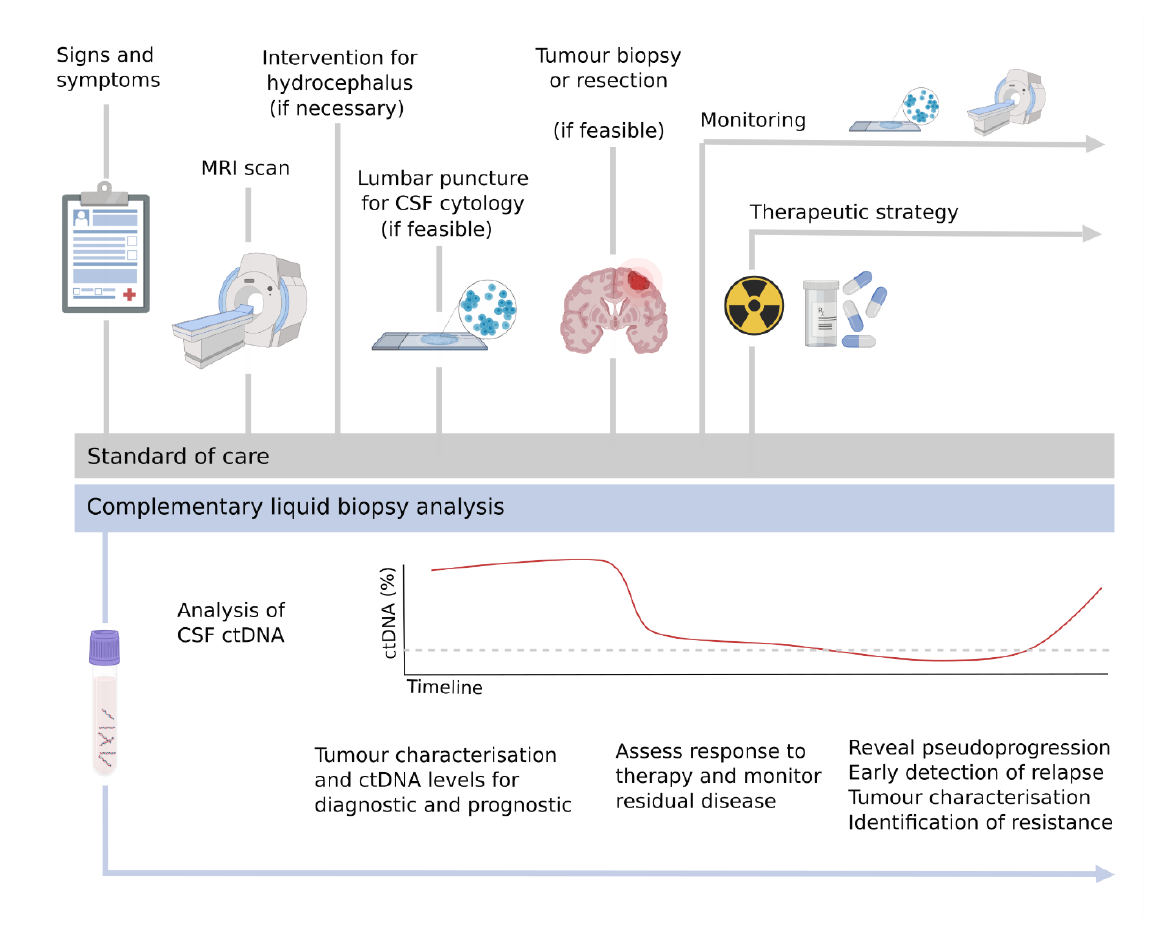
Figure 2. Liquid biopsies in the clinical setting. Schematic representation of the standard of care for patients with CNS malignancies and the complementation with a longitudinal analysis of CSF ctDNA.